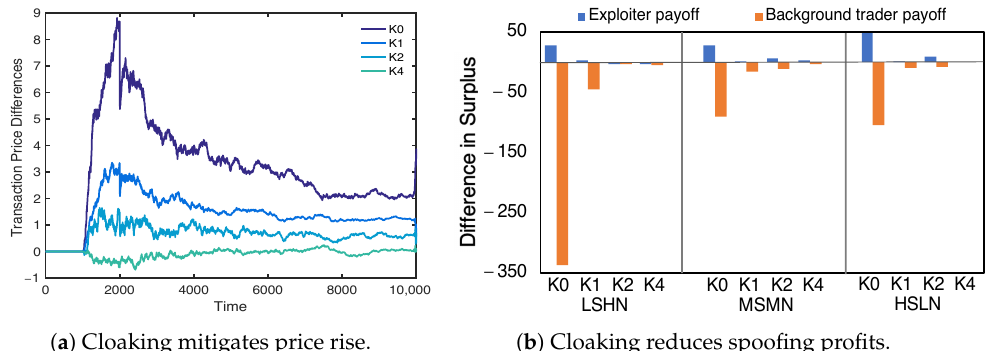
Figure 12. The impact of cloaking on spoofing effectiveness. Cloaking mitigates price rise and the decrease in background surplus caused by